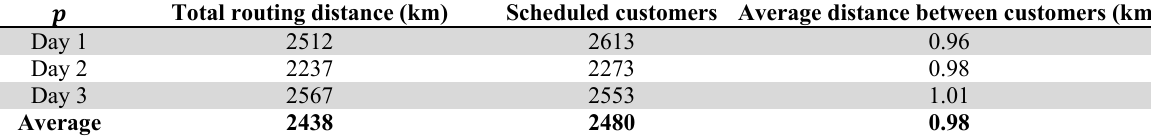
Results of ACO algorithm in routing phase for three days in the case study